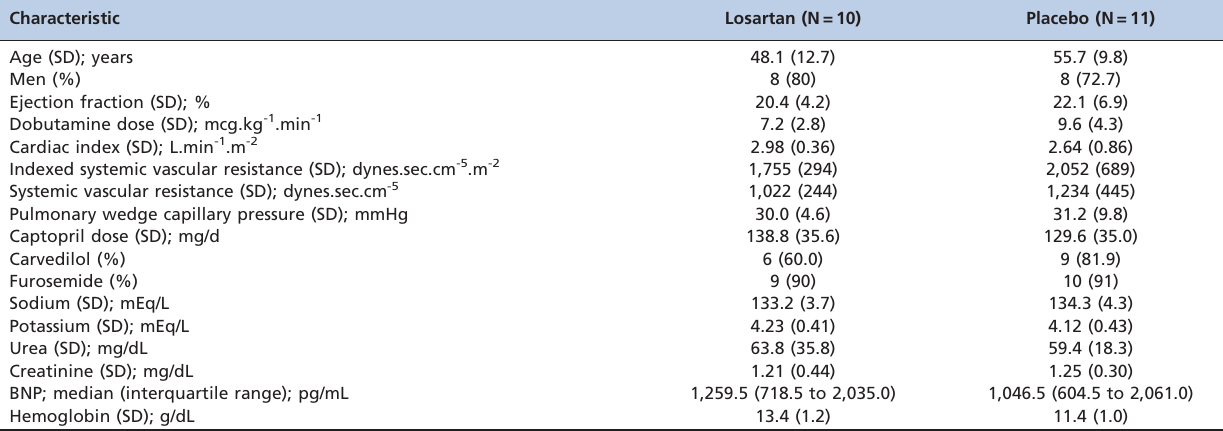
Table 1 - Baseline characteristics.